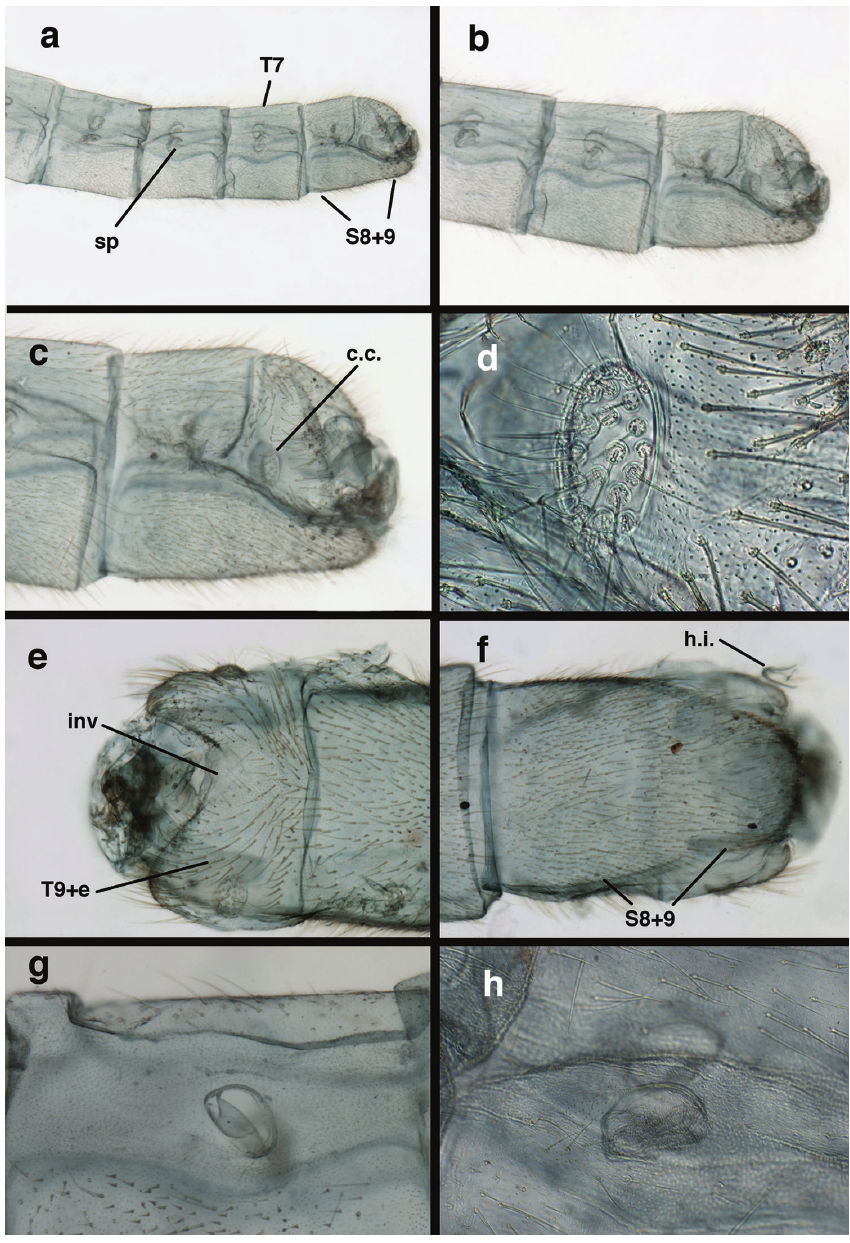
Figure 40. Ungla favrei (Navás): Male abdomen, ( a ) segments A5-terminus, lateral ( b ) segments A7-terminus, lateral ( c ) segment A9+ectoproct, lateral ( d ) callus cerci ( e ) tergite 9+ectoproct, dorsal, with gonarcus inside [Note deep mesal invagination of posterior margin.] ( f ) sternite 8+9, ventral, with large, flanged setae on distal margin ( g, h ) enlarged spiracle (A6). c.c. callus cerci inv. invagination of T9+ectoproct,dorsal surface h.i. hypandrium internum sp spiracle S8+9 fused eighth and ninth sternites T7 seventh tergite T9+e ninth tergite + ectoproct (Bolivia, Cochabamba,